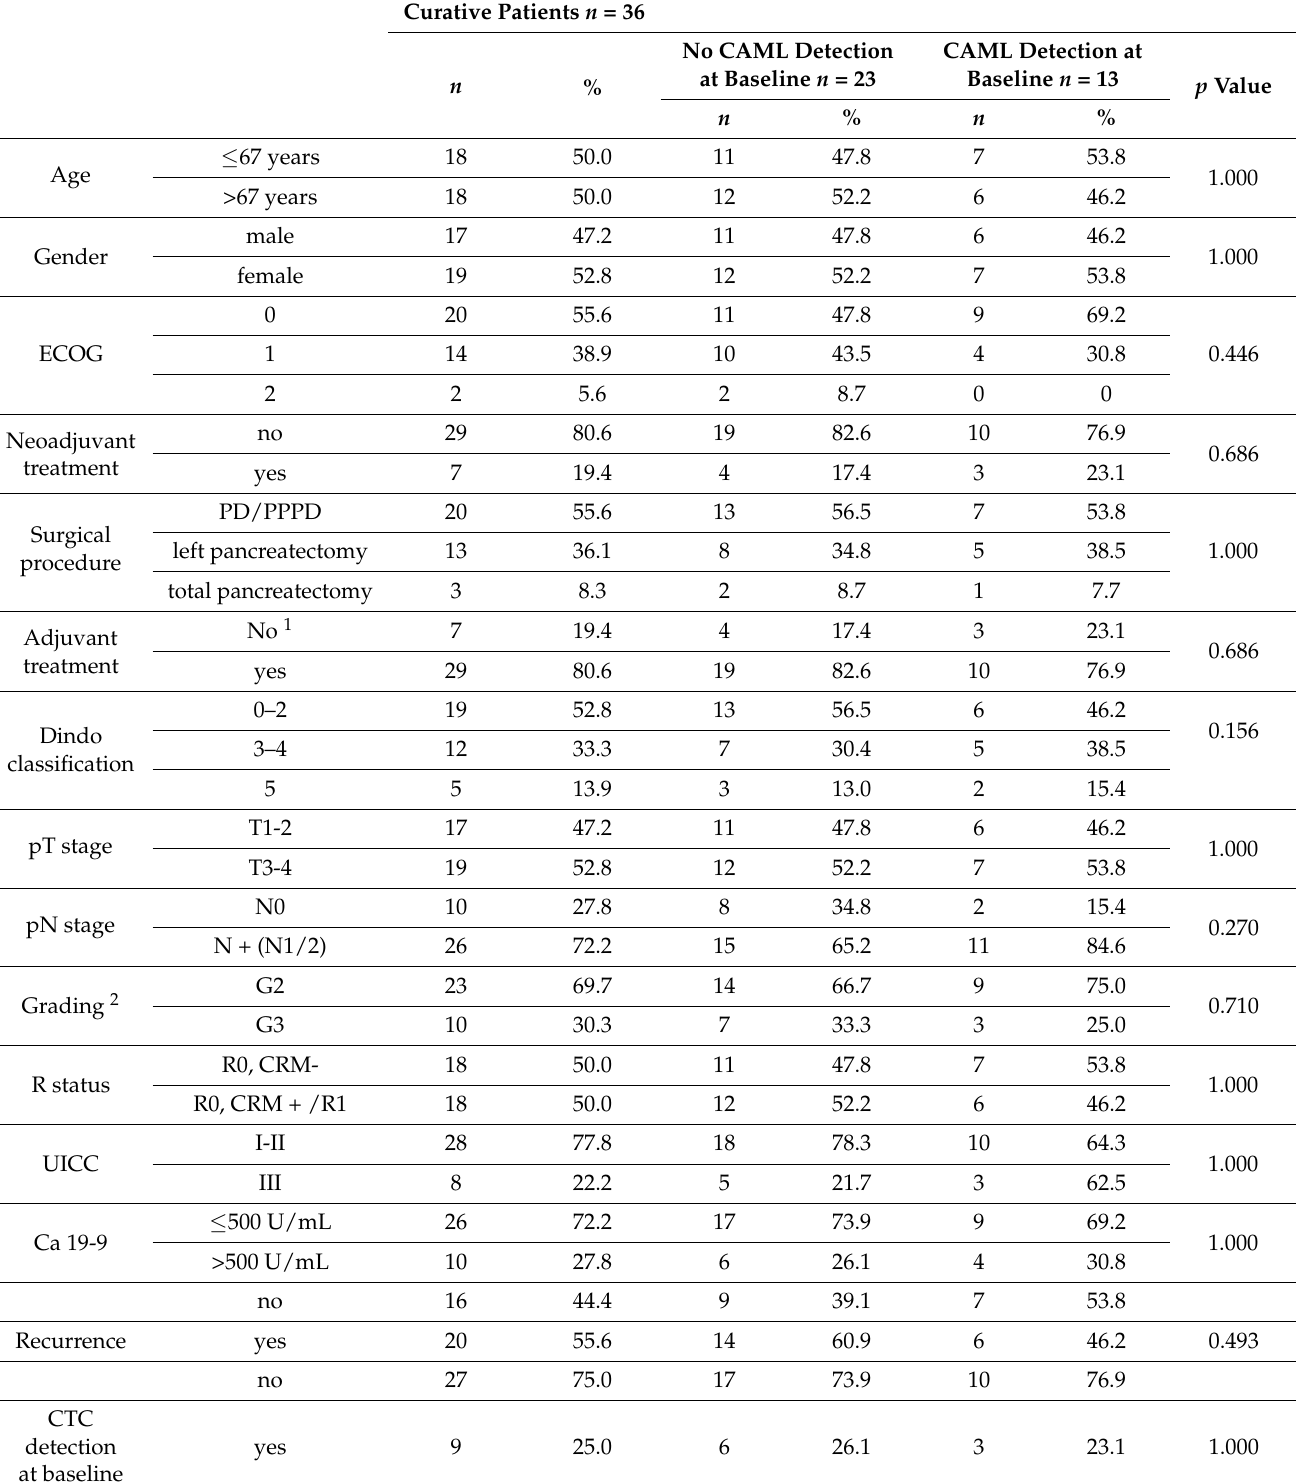
Table 1. Correlation of CAML detection at baseline with clinicopathological parameters in cura- tive